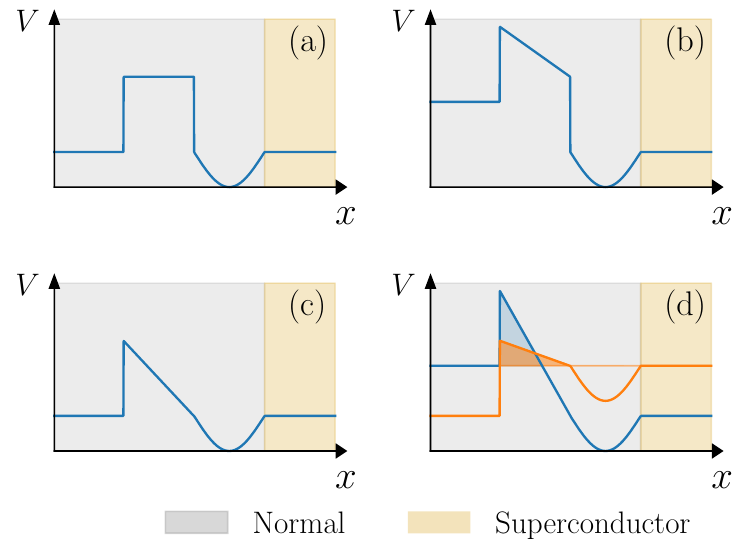
Figure 3: NS junctions with a bias-dependent tunnel barrier and a quantum dot potential. In the top figures we show a square barrier with at (a) zero bias voltage, and (b) negative bias voltage. In the bottom figures we show a triangular barrier at (c) zero bias voltage, and (d) at negative bias voltage (blue curve) and positive bias voltage (orange curve). The shaded regions indicate the effective barrier seen by an incoming electron at E = − eV . When the barrier is triangular shaped, the effective bias barrier at positive voltage is smaller than at negative voltage, thus amplifying particle- hole asymmetry in